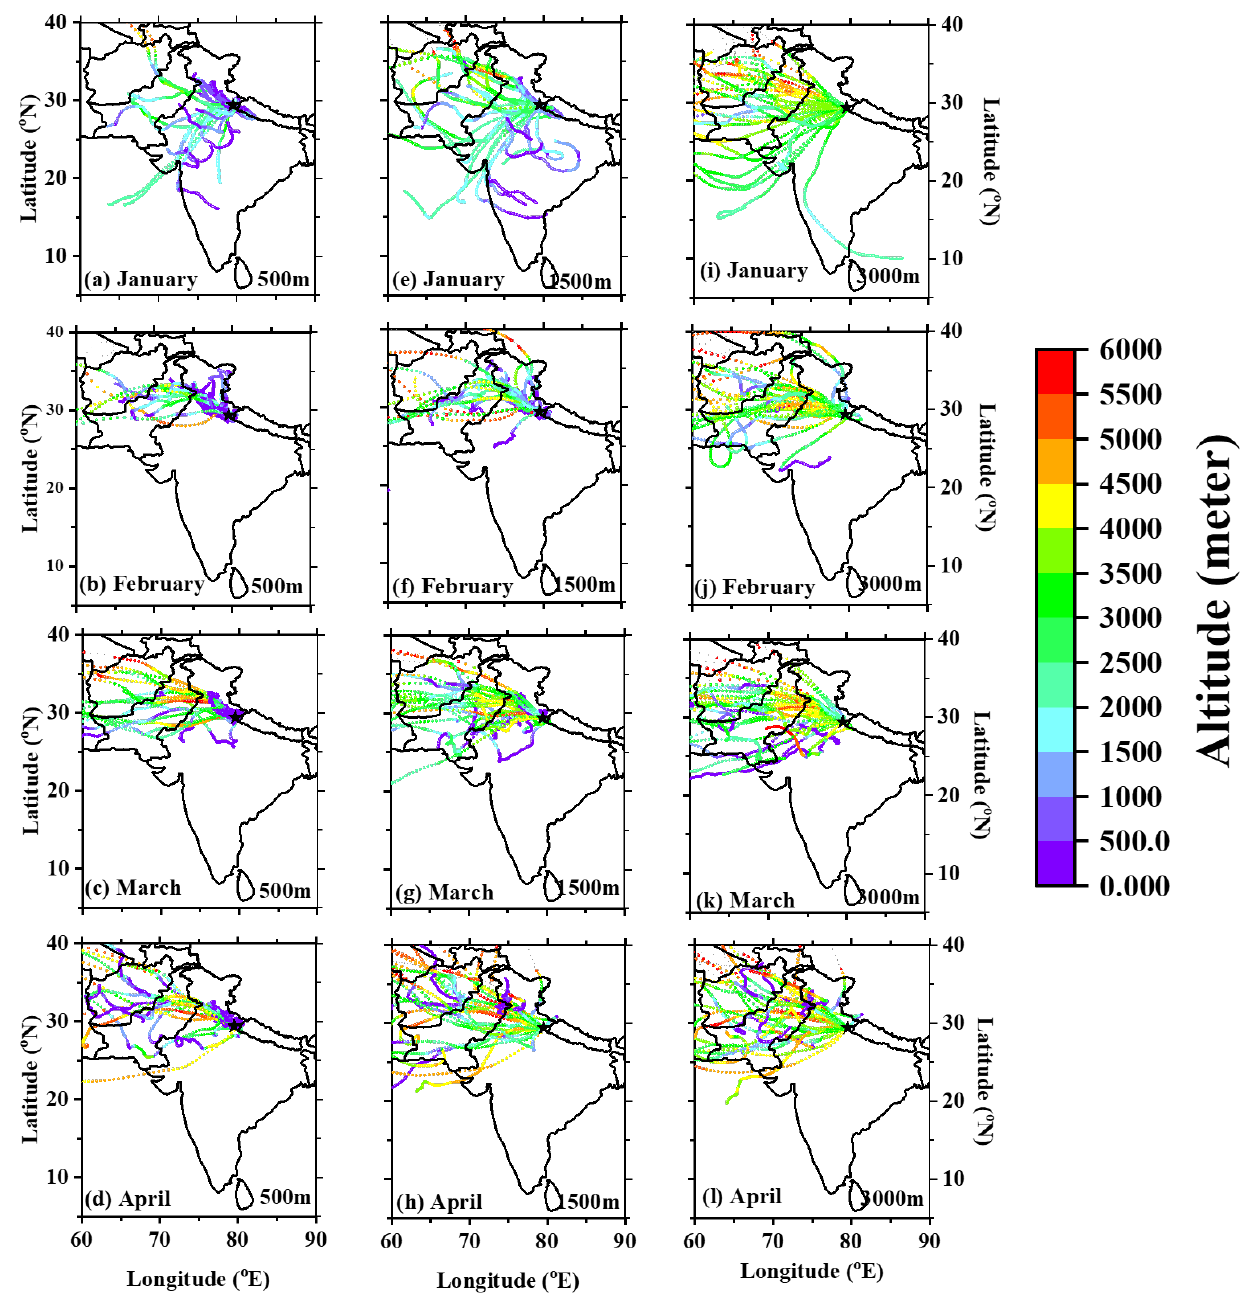
Figure 2. Five-day HYSPLIT airmass back trajectory at three different heights (500 [a-d], 1500 [e-h], and 3000 m [i-l] above ground level) for a high-altitude remote location in central Himalayas (i.e., Nainital) January to April 2021. The color scale shows the traveling altitude by the air mass before reaching at